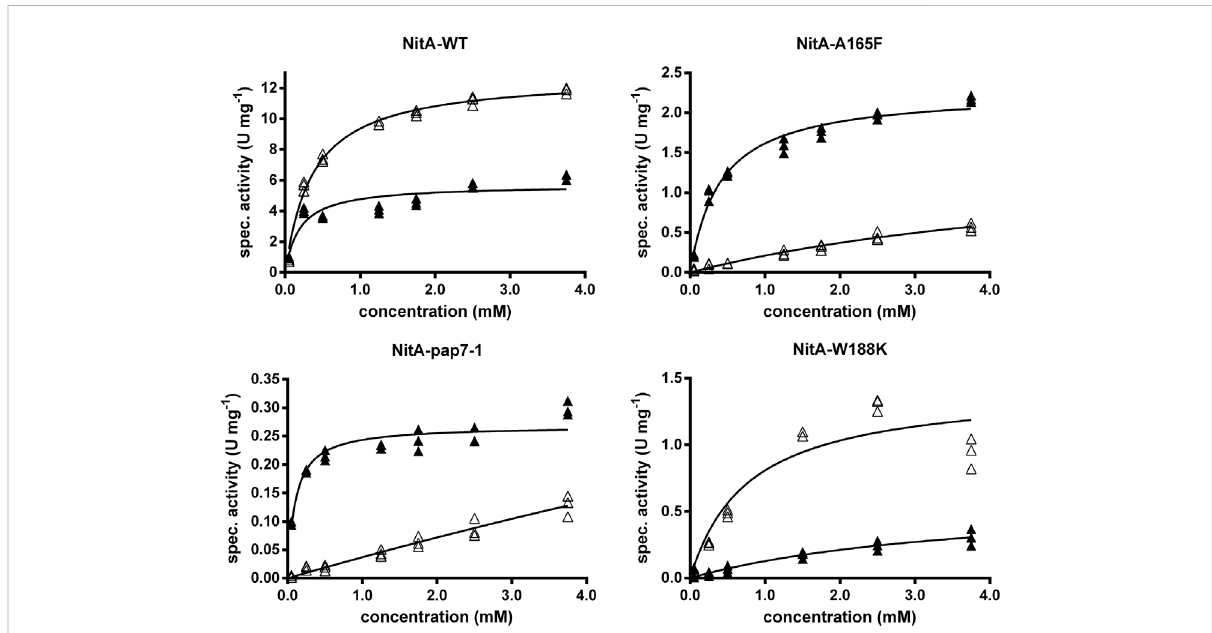
FIGURE 3 Conversionofdifferentconcentrationsof rac -PGNby resting cells of E. coli JM109expressing different nitrilase variants.The reaction mixtures containedin1 ml100 mMNa/K-phosphatebuffer(pH6.0)andrestingcellsoftherecombinant E.coli cells(OD 600nm =0.01 – 0.1).Thereactionswere started by the addition of different concentrations of rac -PGN (0.5 – 10 mM; from 10 – 100 mM methanolic stock solutions). The reaction mixtures were shaken with 750 rpm at 23 ° C and the reactions started by the addition of the substrate. Six aliquots (90 µl each) were taken and the reactions terminated bythe addition of10 µlof 1 M HCland subsequent centrifugation(2 min,14,000 rpm).The concentrations of( R )-PGN and ( S